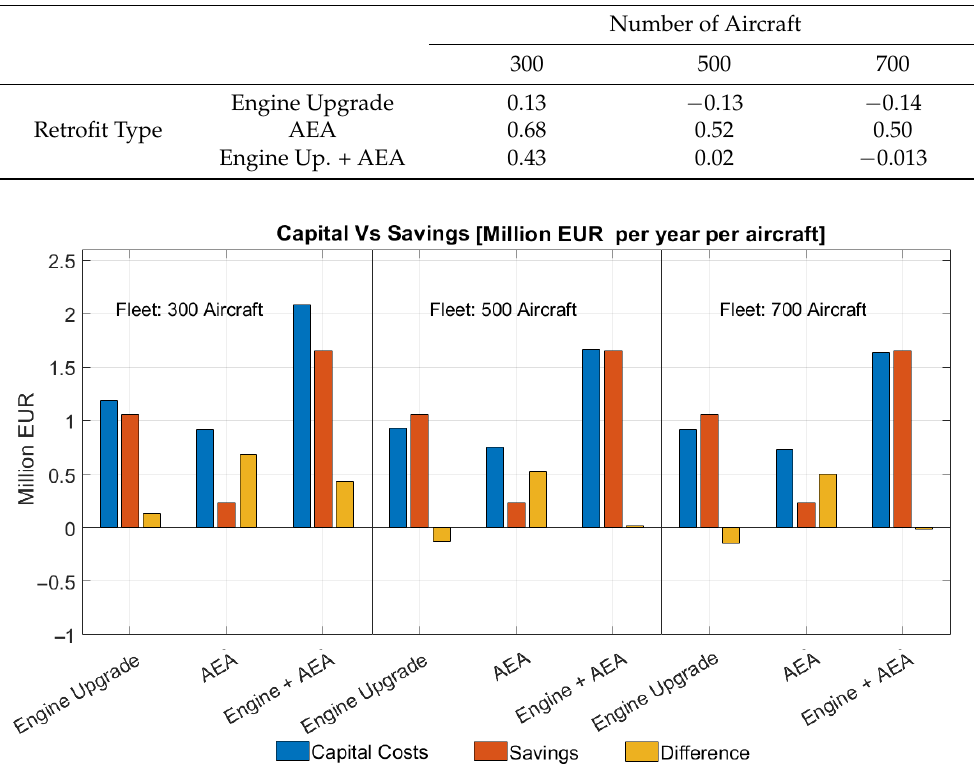
Figure 11. Capital costs and savings and their differences per year per aircraft. A positive difference means that capital cost overcomes savings. Data are shown for three different fleets and three different retrofit solutions.